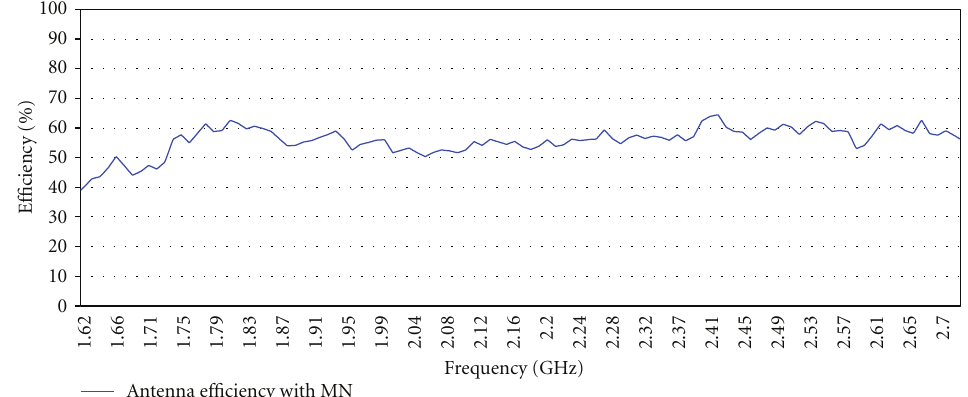
F23:MeasuredantennaefficiencyoftheL-monopoleshowninFigure22.Broadbandmatchingnetworkconsistingofashunt